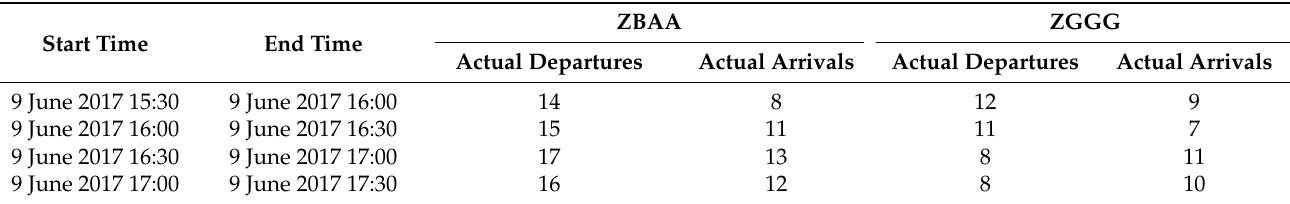
Table 2. An instance of the airport traffic flow